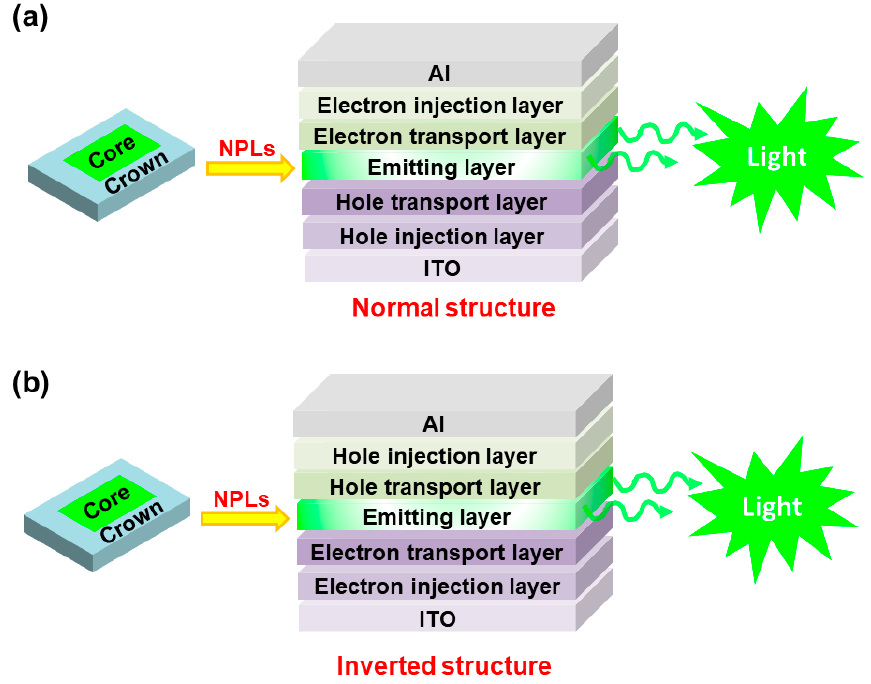
Figure 1. A schematic device architecture of NPL-LEDs. ( a ) Normal structure; ( b ) Inverted structure.